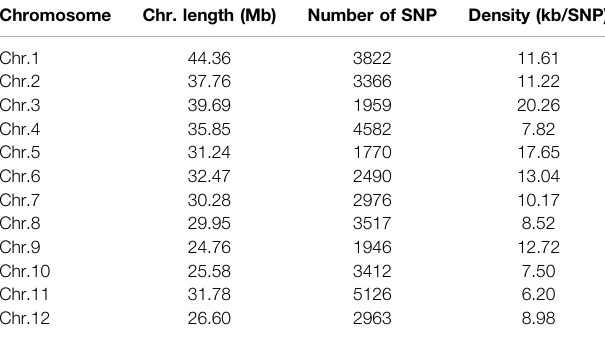
46 accessions of the POP4 subgroup were mainly from Japanese breeding lines. According to the analysis results, varieties from the same country tended to be clustered together.